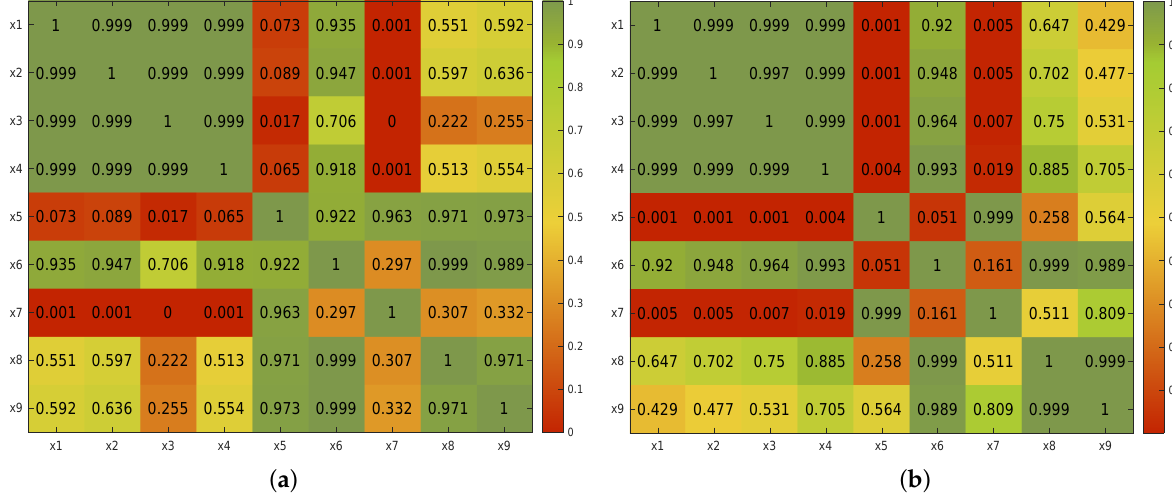
Figure 3. Occipital region. Comparisons of p -values obtained with ANOVA by pairs. ( a ) N100 amplitude. ( b ) P200 amplitude. 1 0.999